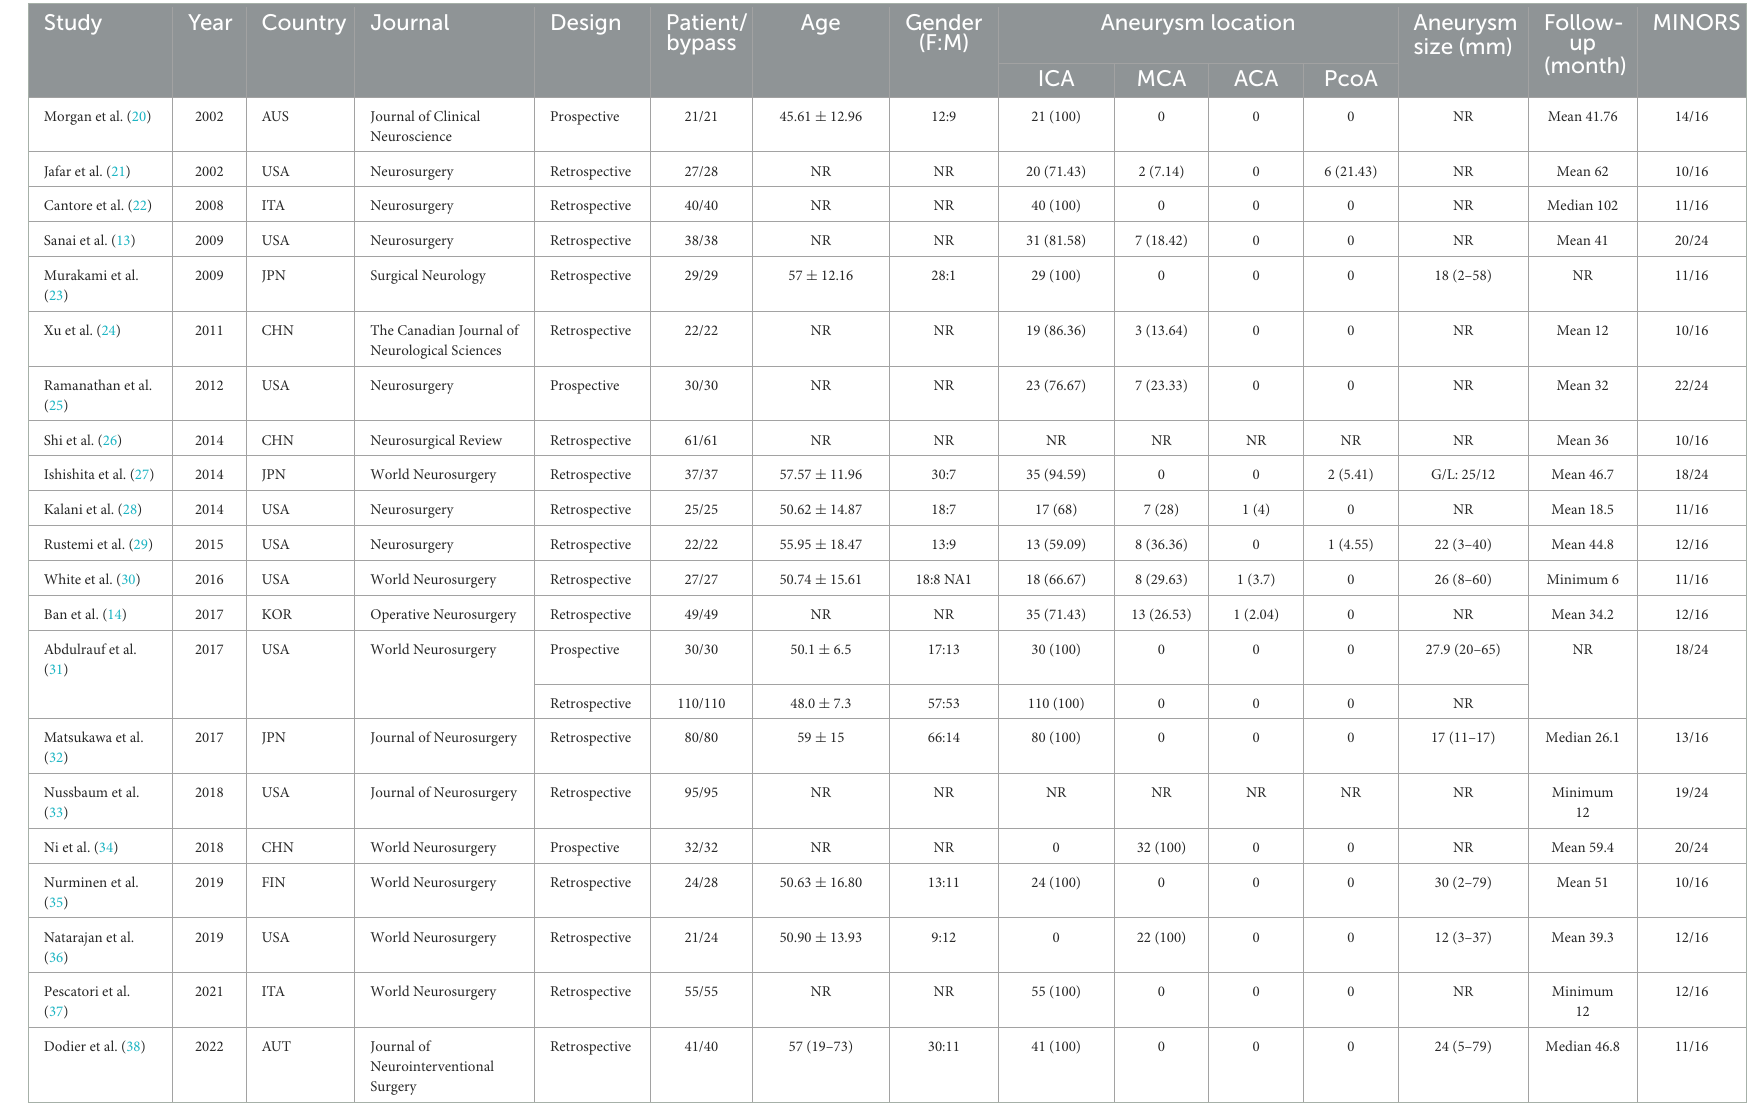
TABLE 1 Characteristics and quality of included studies.